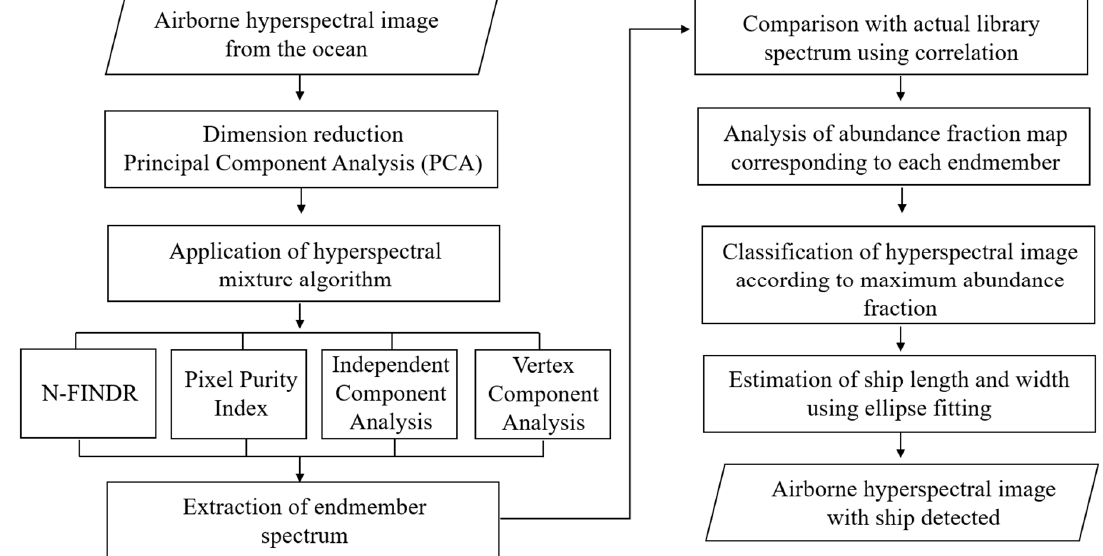
Figure 4. Flowchart of hyperspectral image data analysis for vessel detection.